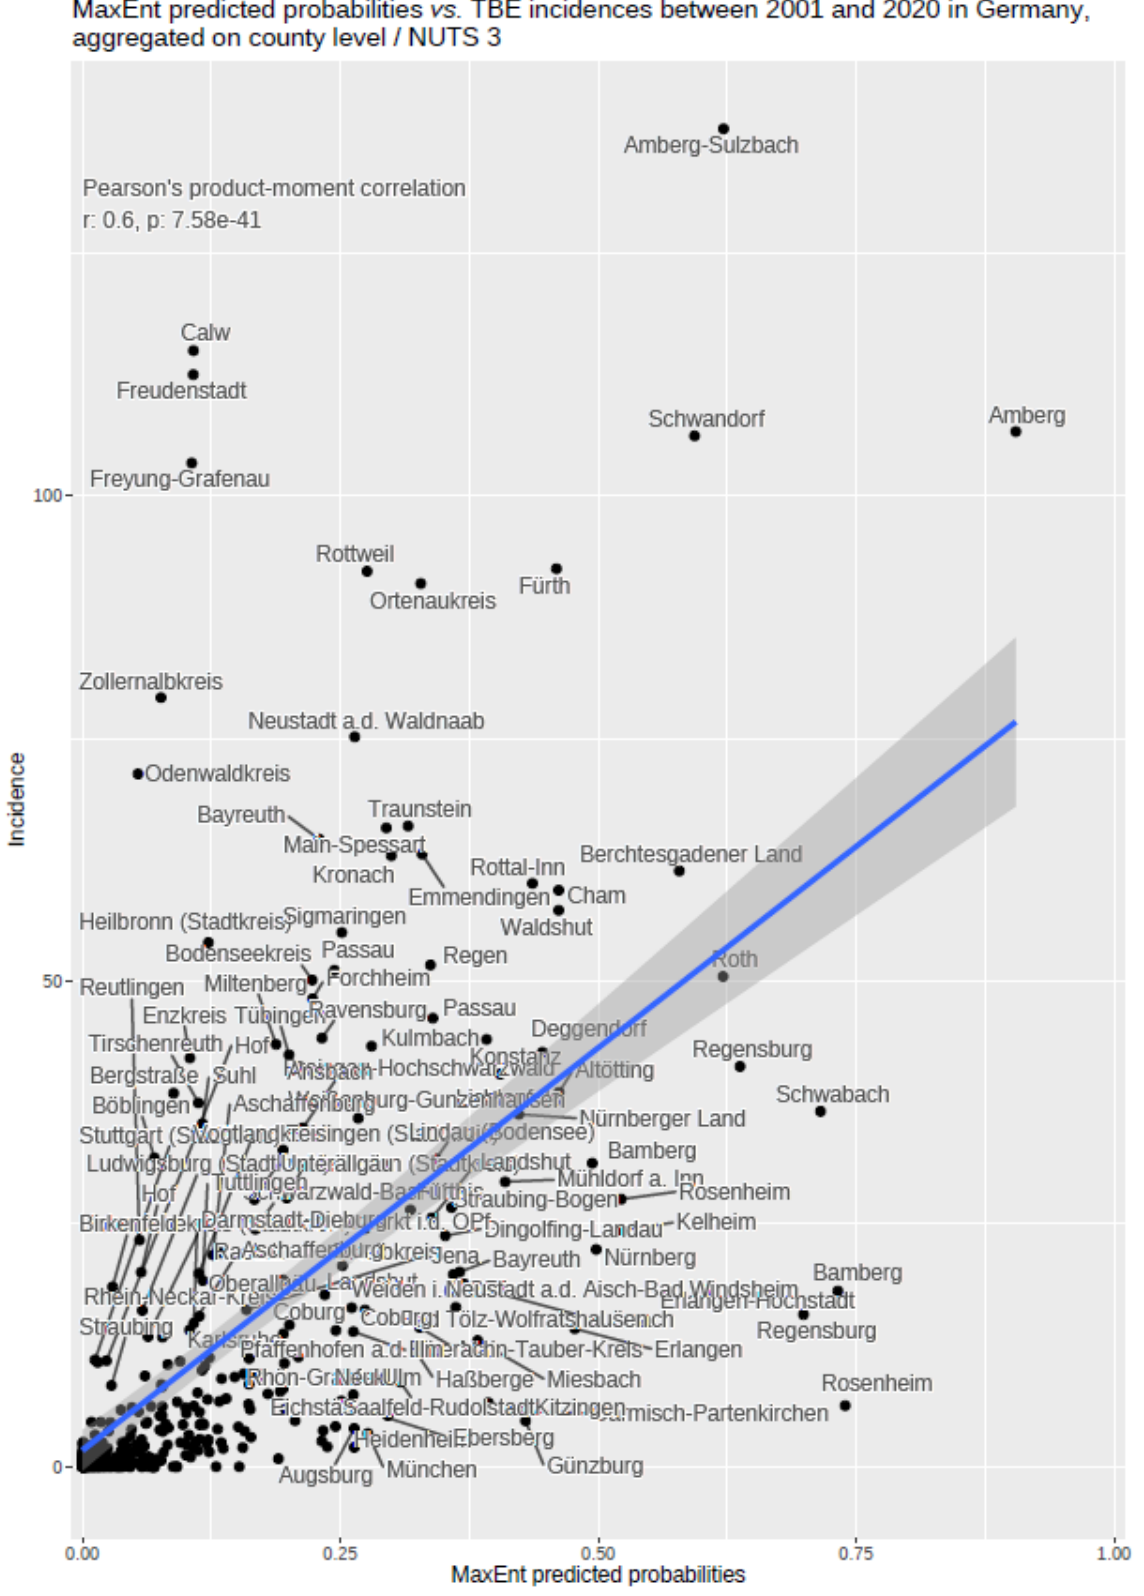
Figure 8. MaxEnt predicted probabilities correlated with TBE incidences between 2001 and 2020 in Germany, data are aggregated on NUTS 3 level. The inset shows the results of Pearson’s product– moment correlation.